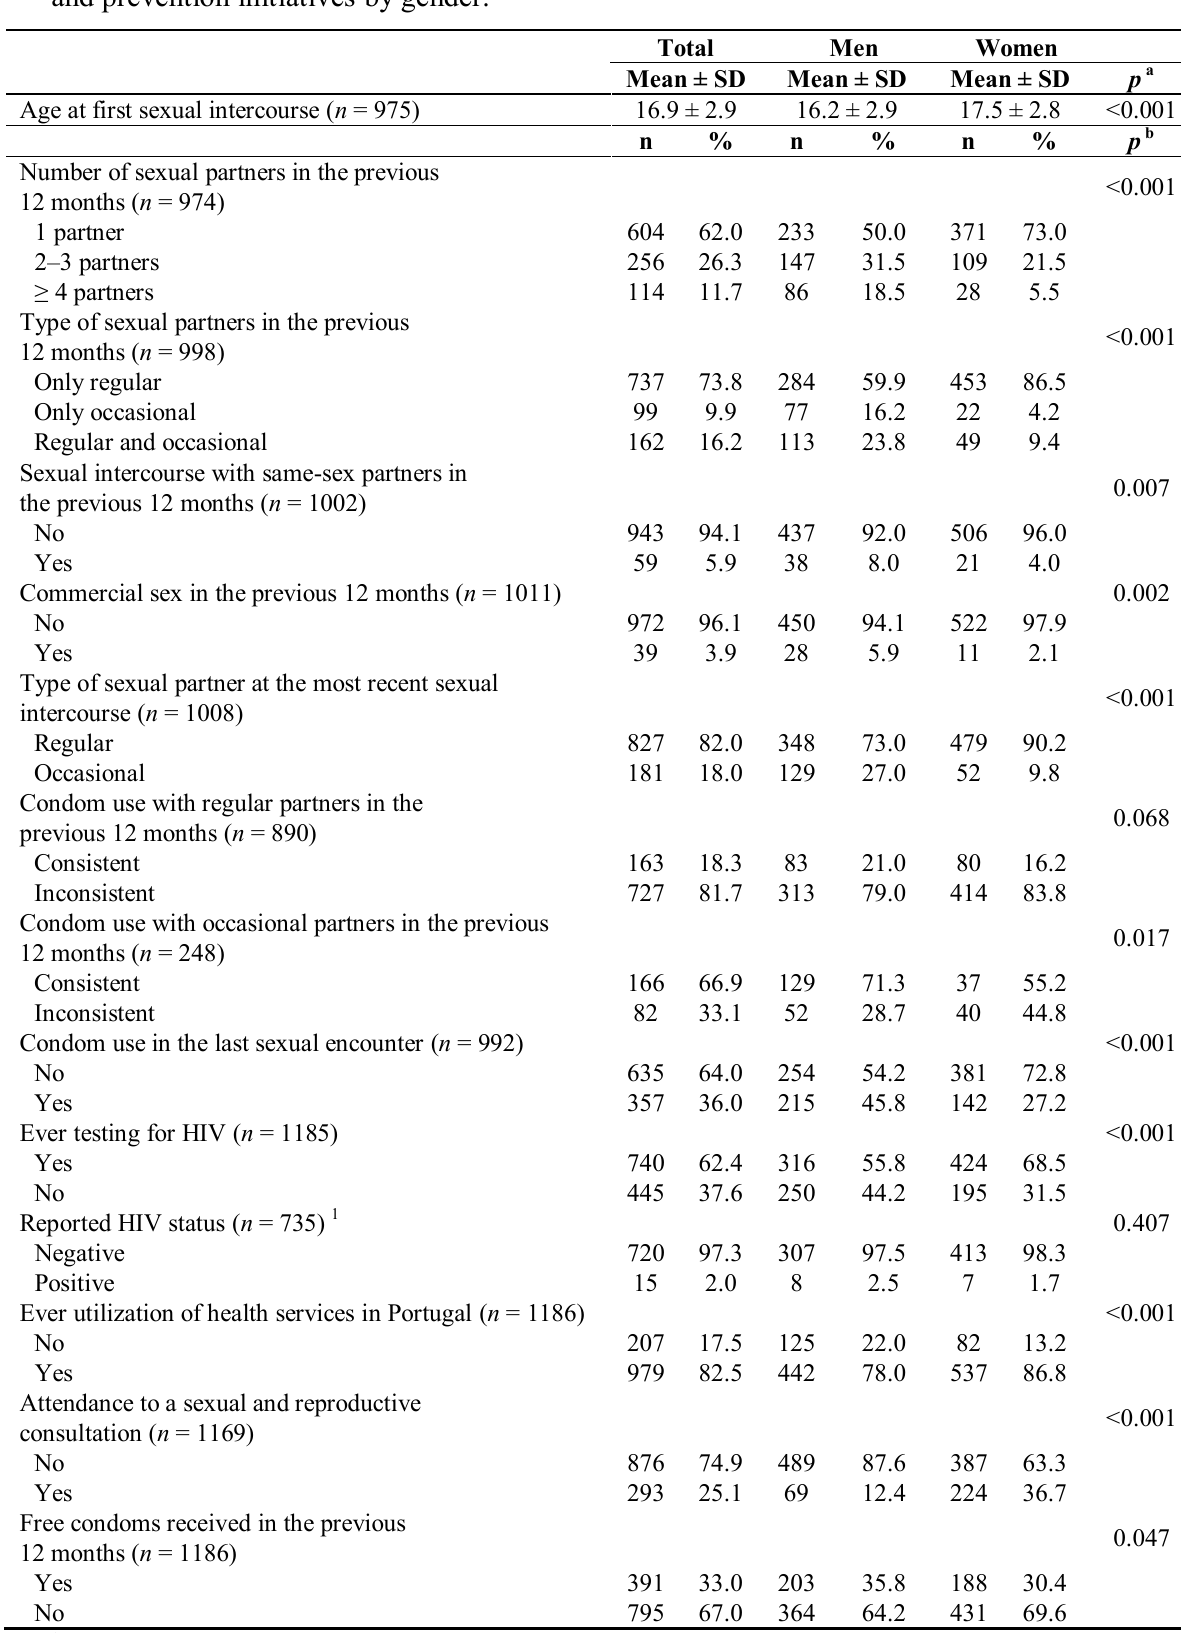
Table 2. Risk sexual behaviors, HIV testing, reported HIV infection, use of health services and prevention initiatives by gender. Total Men Women Mean ± SD Mean ± SD Mean ±